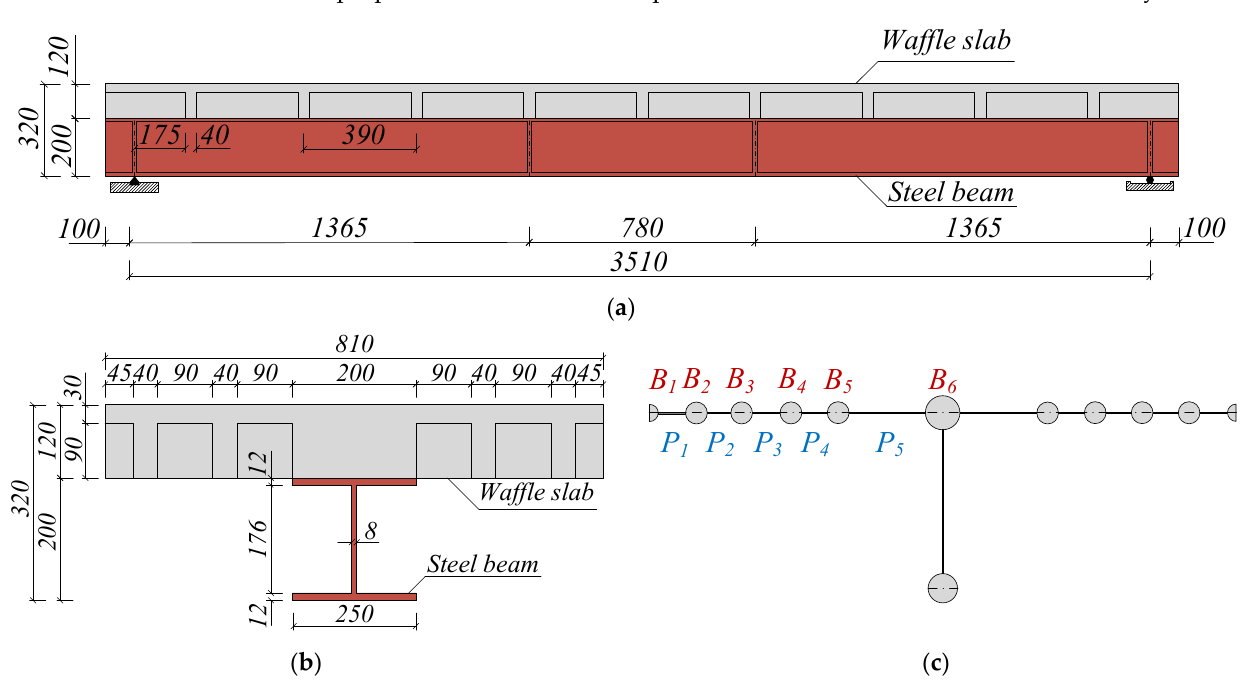
Figure 13. Dimension of specimen SU-WSCS (unit: mm): ( a ) side view; ( b ) typical cross-section; ( c ) simplified structure. Table 2. λ max comparison in SU-WSCS.